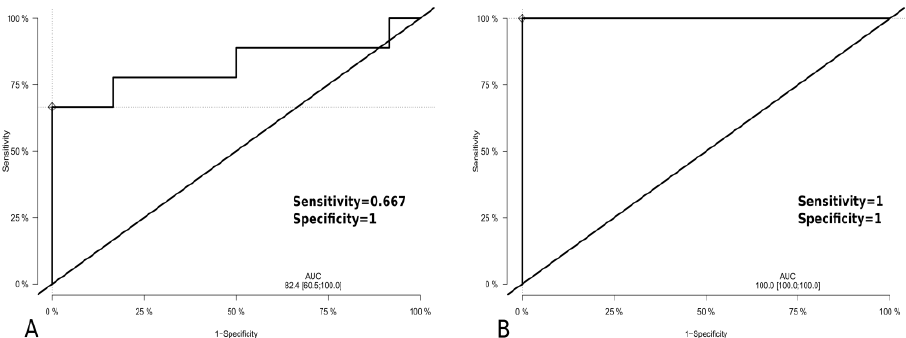
Figure 4. ROC analysis of the performance of a combined miR-16-5p, miR-21-5p, miR-92a-3p and miR-423-5p expression to discriminate primary diffuse large B-cell lymphoma of the central nervous system (CNS DLBCL) and non-malignant CNS lesions (n-ML) in ( A ) CSFs (CNS DLBCL, n = 9; n-ML, n = 12) and ( B ) tumor samples (CNS DLBCL, n = 10; non-ML, n = 10).